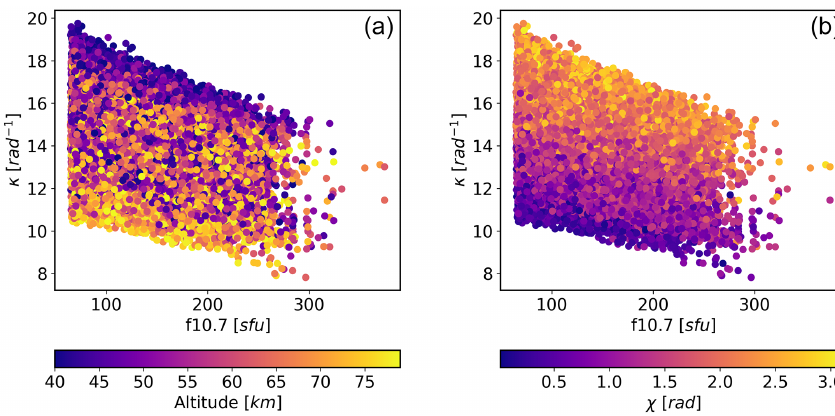
Figure 12. κ vs. F10.7, colour coded by altitude (a) and solar zenith angle ( χ ) (b) . 1sfu = 10 − 22 Wm − 2 Hz − 1 .